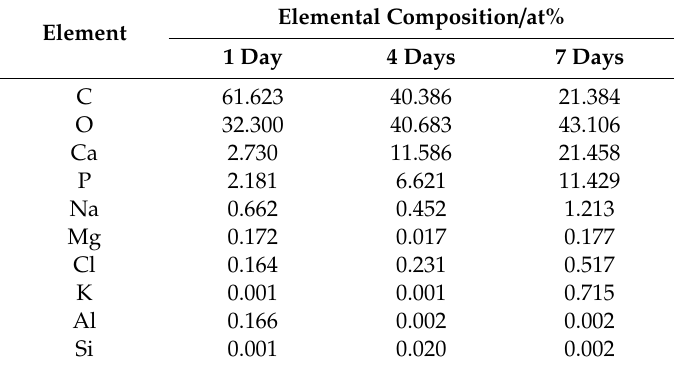
Figure 5. ( a , c , e ) SEM micrographs and ( b , d , f ) EDX profiles of the surface of Sample SGA after immersion in SBF for ( a , b ) 1 day, ( c , d ) 4 days and ( e , f ) 7 days. Table 1. Elemental composition of the surface of Sample SGA after immersion in SBF for each period calculated from the EDX profiles shown in Figure 5 (except Au generated by sputtering).